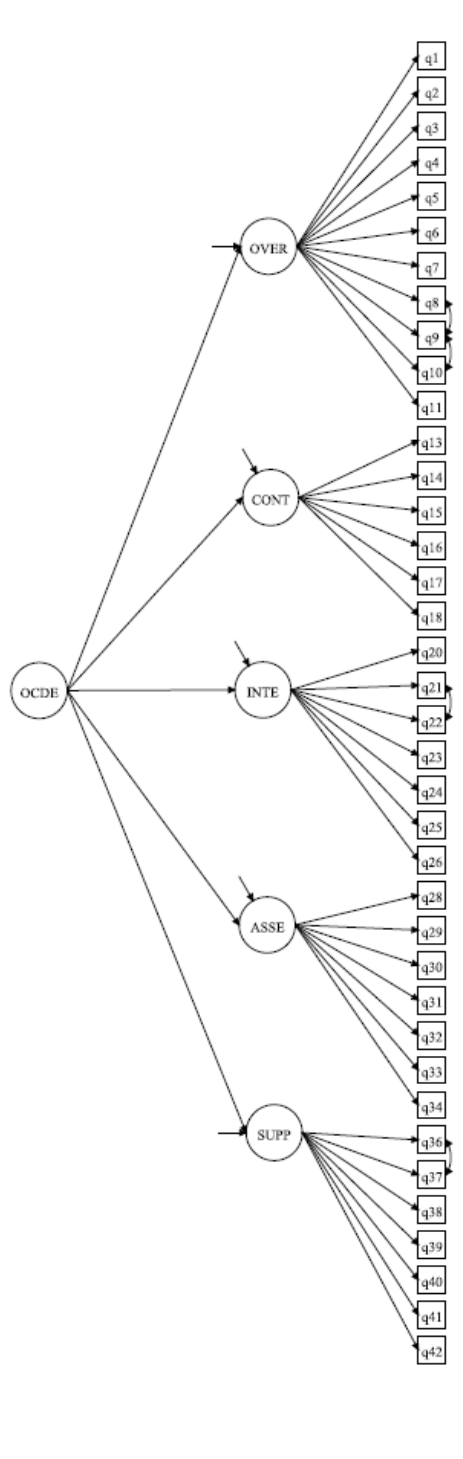
Best Fitting Higher-Order